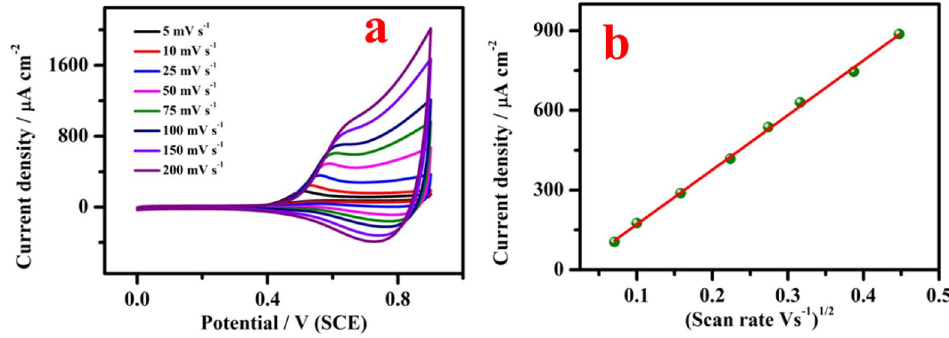
Figure 8. ( a ) Effect of scan rate on the CV of CuO/GCE in 2 mM of SO 32− at varying the scan rate from 5, 10, 25, 50, 75, 100, 150 and 200 mV s -1 and ( b ) corresponding plot of peak current versus square root of scan